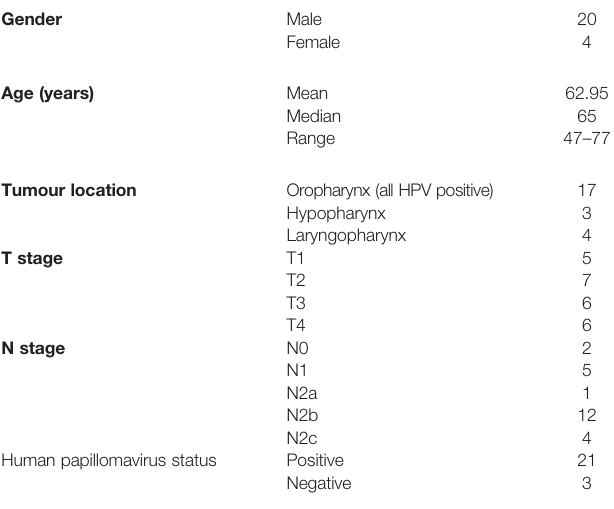
TABLE 1 | Participant characteristics of the HNSCC cohort.